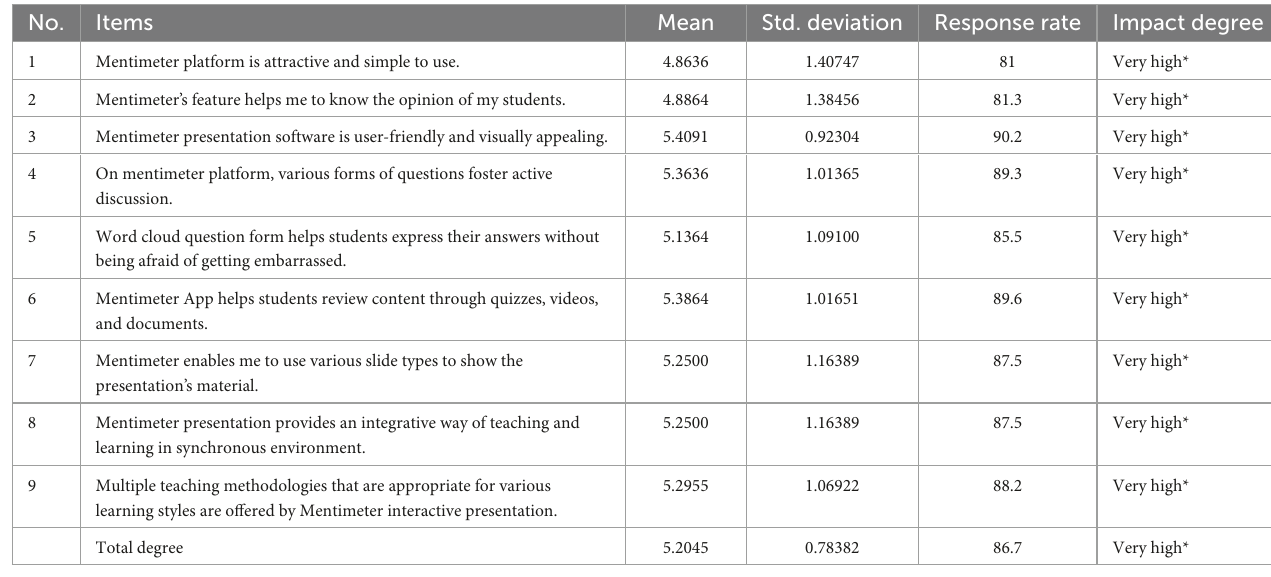
TABLE 7 Mean and standard deviation of the respondents’ answers (dimension two). No. Items Mean Std. deviation Spontaneous participation is facilitated by mentimeter’s quiz feature.